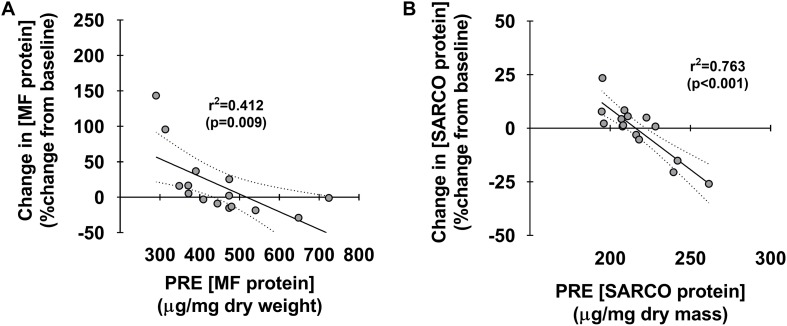
Associations between pre-training muscle protein levels versus percent change in these metrics. Associations between pre-training myofibrillar and sarcoplasmic protein concentrations versus PRE to POST percent changes in these metrics (A,B, respectively). For each panel, regression lines are solid and 95% confidence interval bands are dashed.